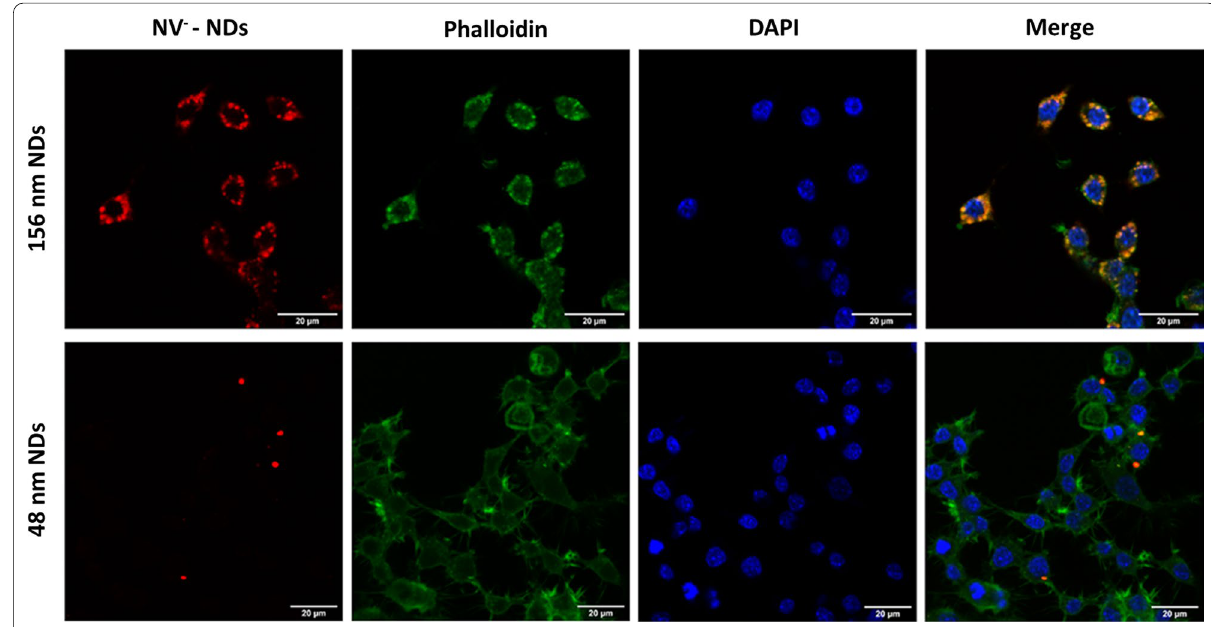
Fig. 4 Confocal Microscopy images of RAW 264.7 cells incubated for 24 h with 48 nm and 156 nm NDs. After adding NDs (red) cells were stained with Phalloidin (green). Nuclei were counterstained with DAPI (blue). The “merge” figure demonstrates the internalization of the NDs (orange) within the cells. Cellular uptake of the 156 nm NDs is much higher than that of the 48 nm NDs. Scale bars